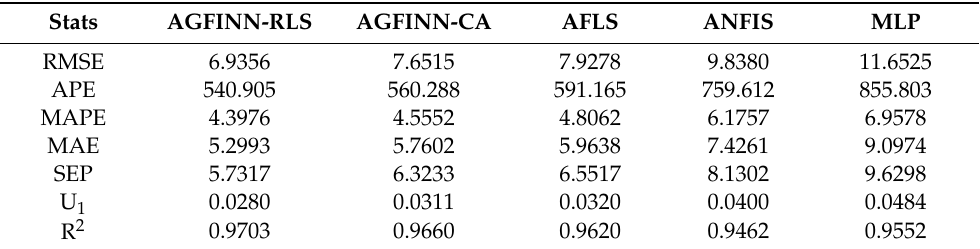
Table 3. Statistical performances for electricity price forecasting models at 22:00—case study 2.